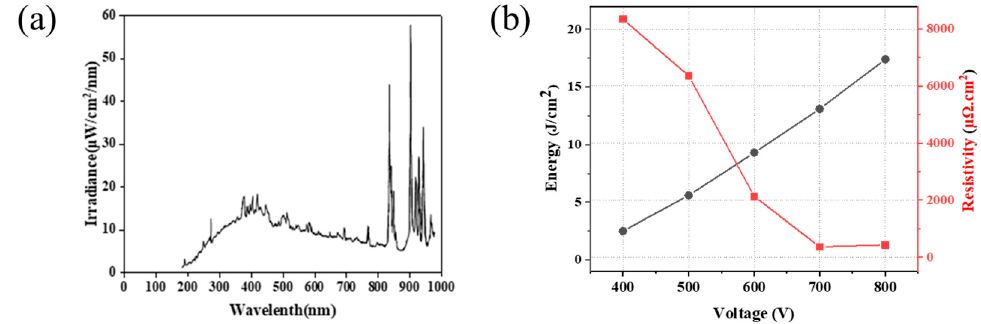
Figure 10. Typical instantaneous spectral distribution of ( a ) irradiance and ( b ) single-pulse energy generated by an IPL xenon lamp.